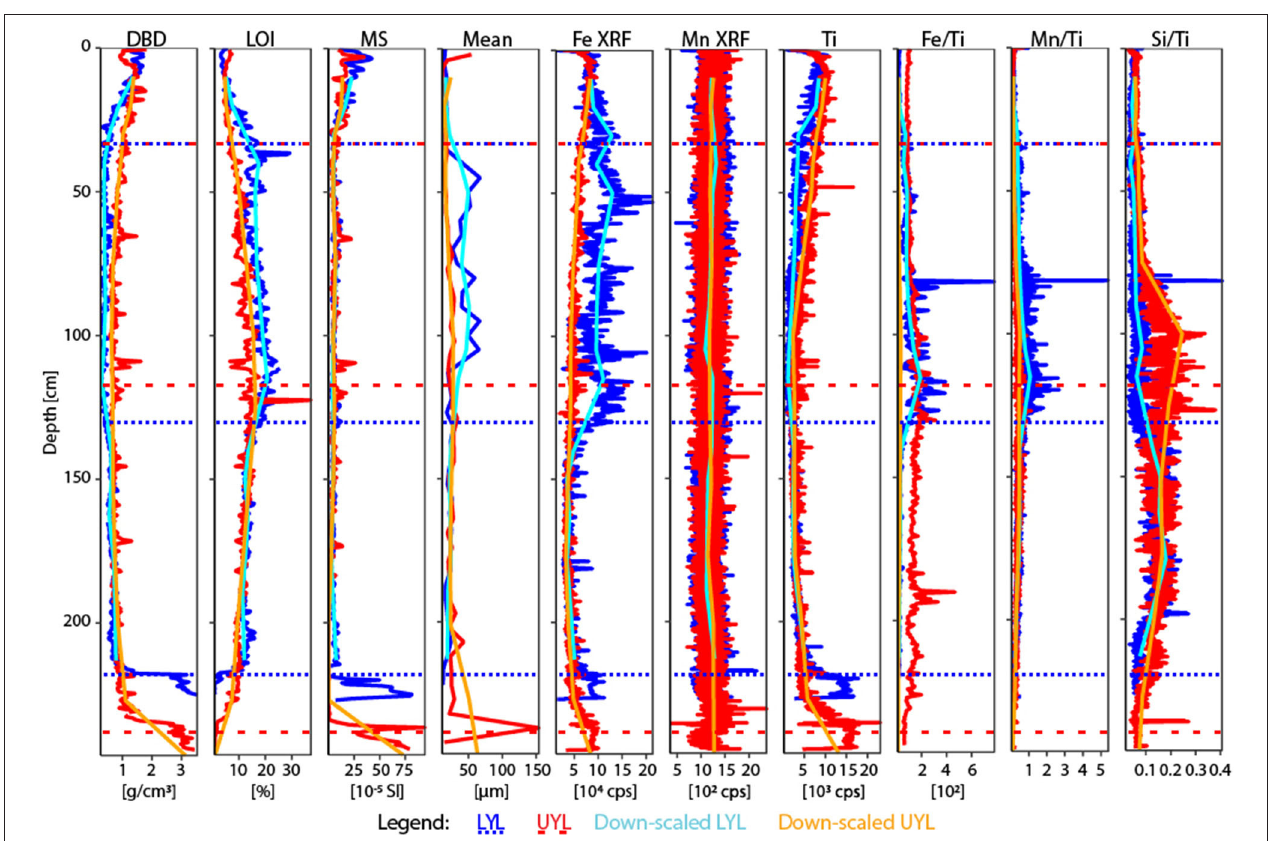
FIGURE 3 | Physical and XRF proxy variables used in the study, plus additional redox-sensitive ratios Mn/Ti and Si/Ti. Mean is mean grain size. Blue line: LYL, high resolution; red line: UYL, high resolution; cyan line: LYL, upscaled resolution; orange line: UYL, upscaled resolution. Horisontal dotted and dashed lines refer to lithological separation into units for LYL and UYL, respectively. For XRF data, upscaling was performed using a running average of n = 50 for neighbours on either side of the center point. For DBD, LOI and MS, n = 4 and for mean grain size, n =